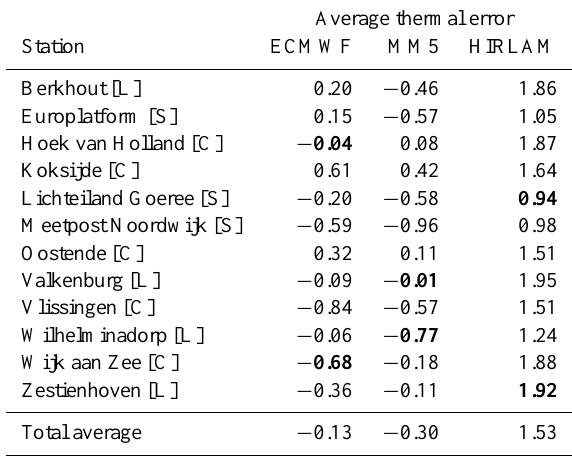
Table 2. Average thermal error ( ◦ C) over the time period between 12 August 2004 12:00 UTC and 13 August 2004 12:00 UTC for several synoptic stations. Inland stations are represented by [L], coastal stations by [C] and sea stations by [S]. Valkenburg, situated at 3km from the coast, is counted as coastal